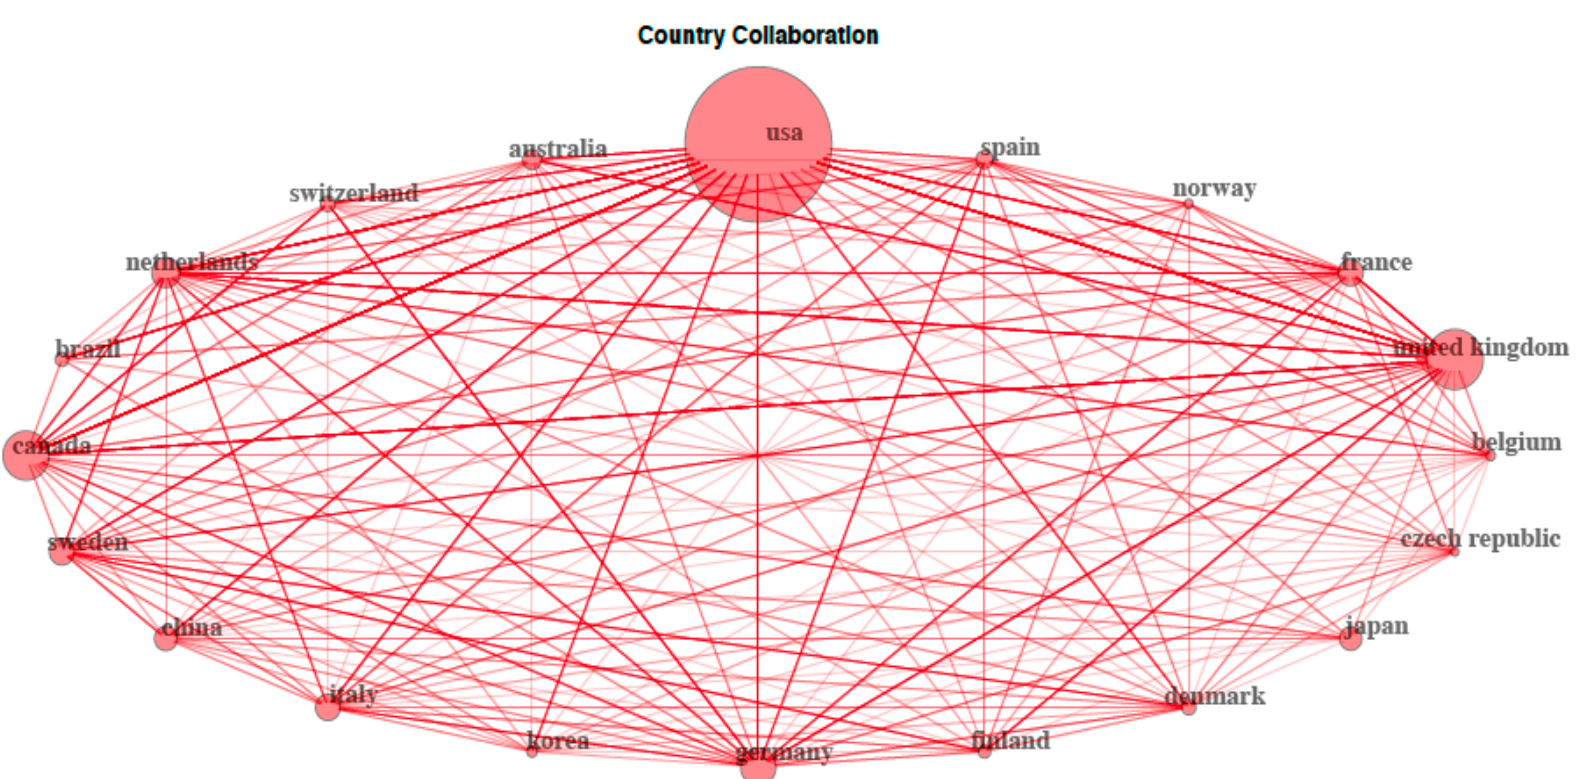
Figure 4. Country collaboration network map. Each link shows a collaboration between two countries and larger circle size indicates a higher number of international collaborative projects conducted by each country.